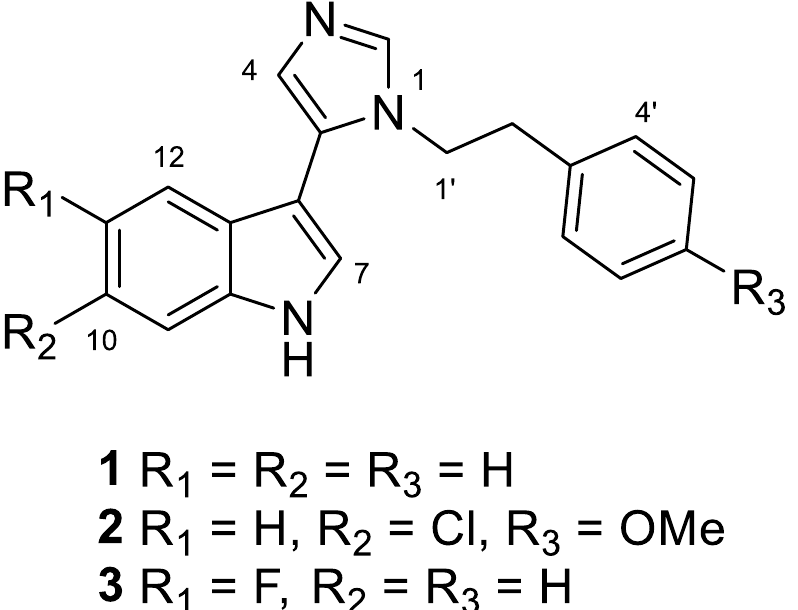
Figure 1. Structures of indole-imidazole compounds 1 – 3 .